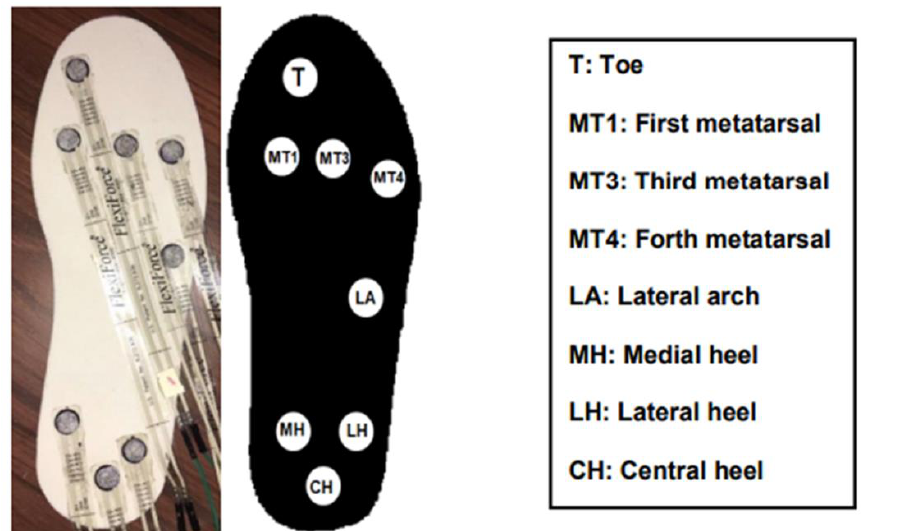
Figure 4. The exact locations of the sensors on the insole.